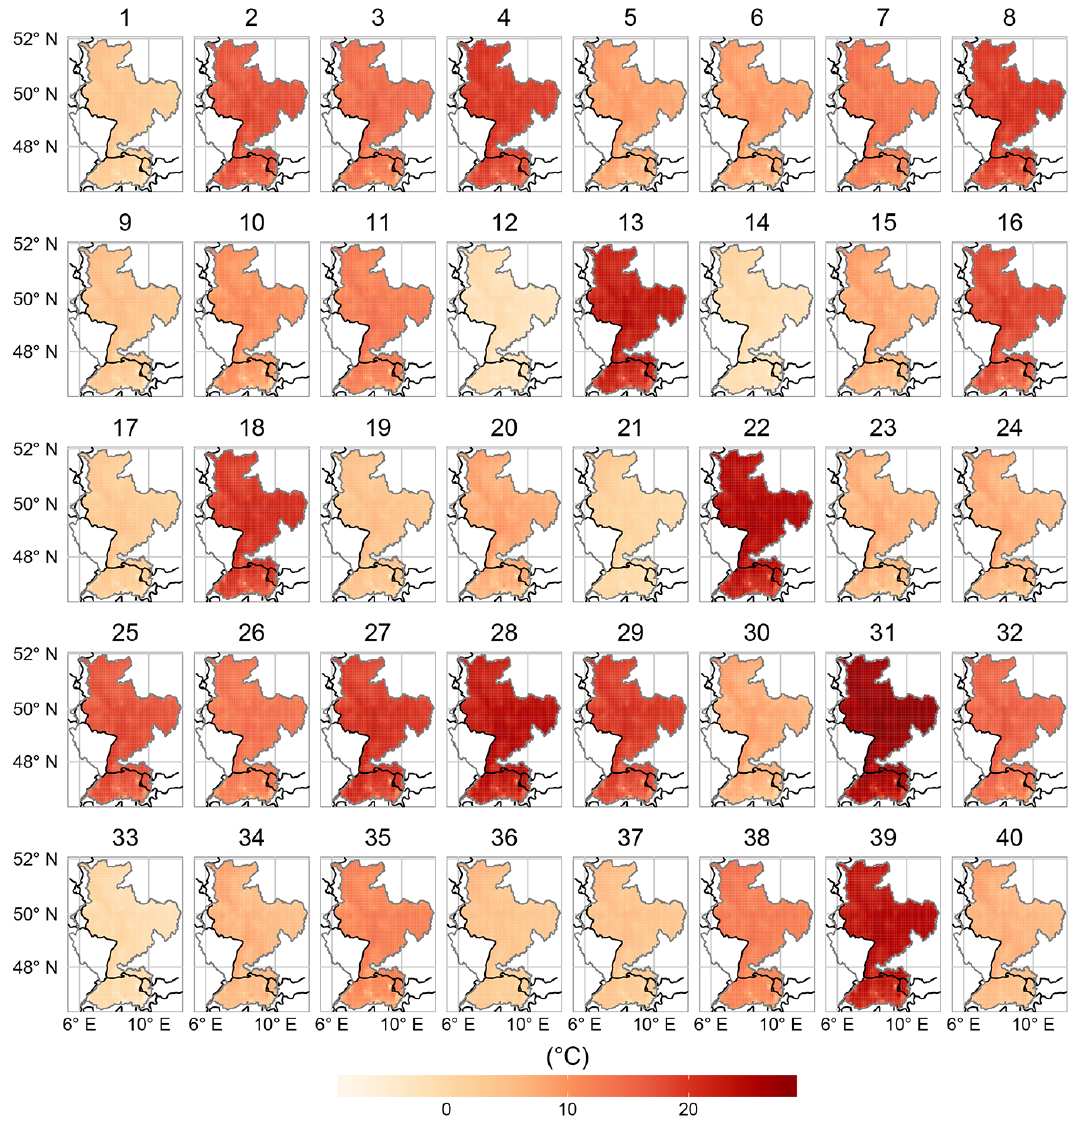
Figure A5. As in Fig. A1 but for daily maximum